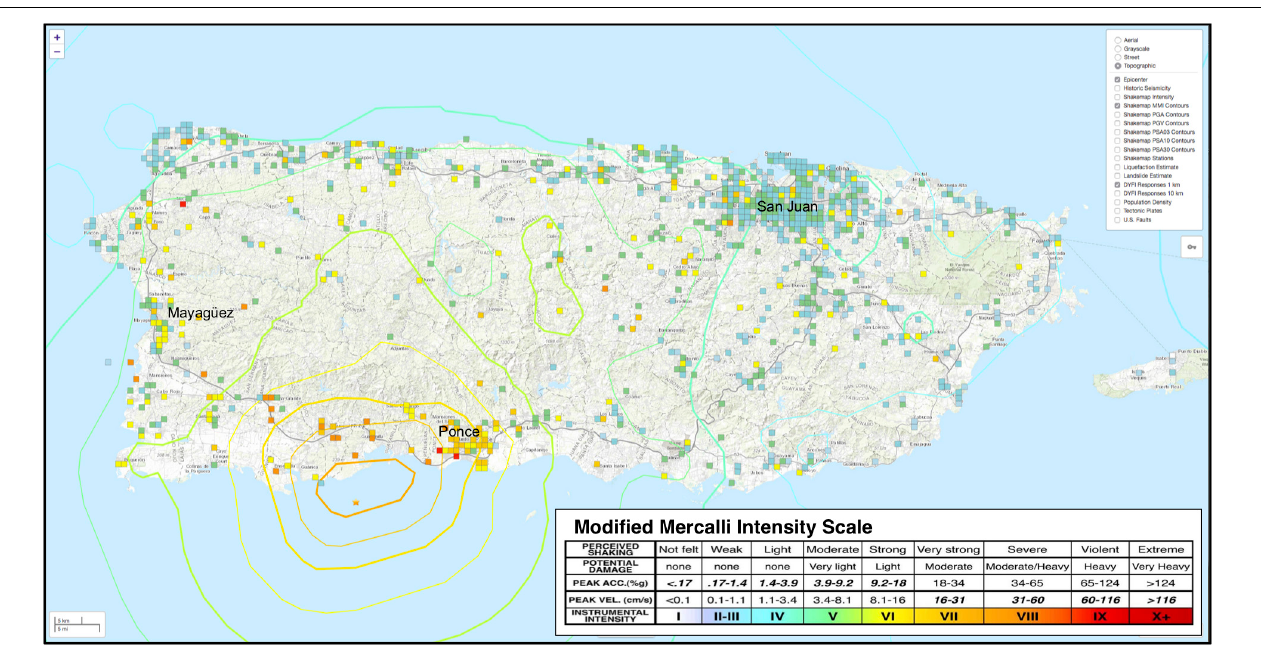
FIGURE 2 | Interactive map from the USGS event web pages for the 2019 magnitude 6.4 Indios, Puerto Rico earthquake at a regional scale. Over 2,500 DYFI data in the region are displayed in 1-km square blocks color-coded to the inset legend used by DYFI and ShakeMap to show the intensity (Wald et al., 2011). ShakeMap isoseismal contours are shown using the same color scheme (Source: U.S. Geological Survey).